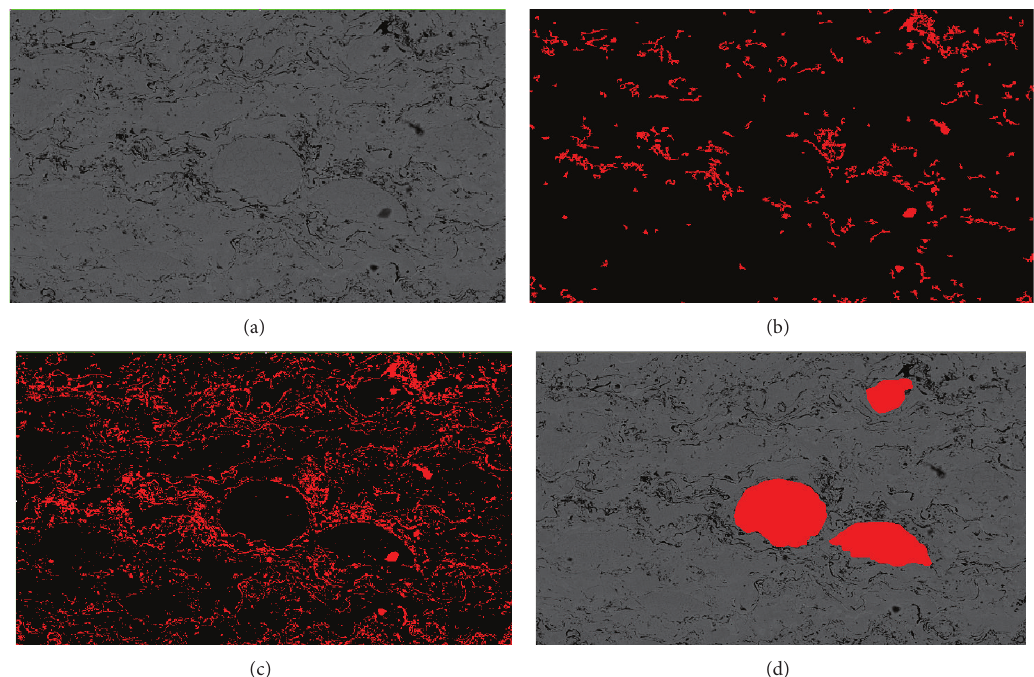
Figure 5: Image analysis of the coatings Co 32 Ni 21 Cr 8 Al 0.5 Y, showing (a) original image, (b) content of oxides and pores, (c) porosity, and (d) unmelted